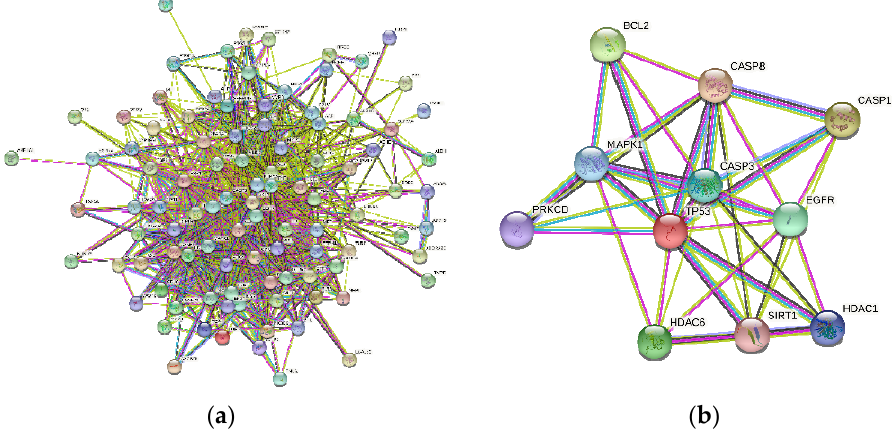
Figure 3. The PPI network analyzed visualized by Cytoscape software. ( a ) PPI network of 99 overlapping genes between osmanthus fragrans and osteogenesis-related genes. ( b ) PPI network of 11 overlapping genes of osmanthus fragrans, autophagy-, and osteogenesis-related genes.